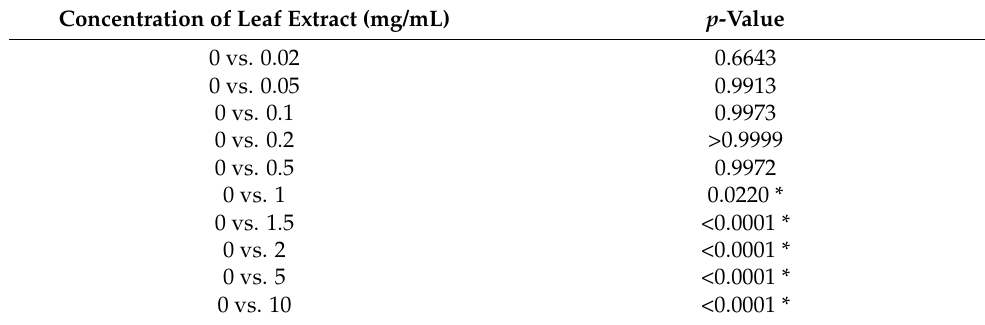
Table 1. Dunnett’s Multiple Comparisons Test.